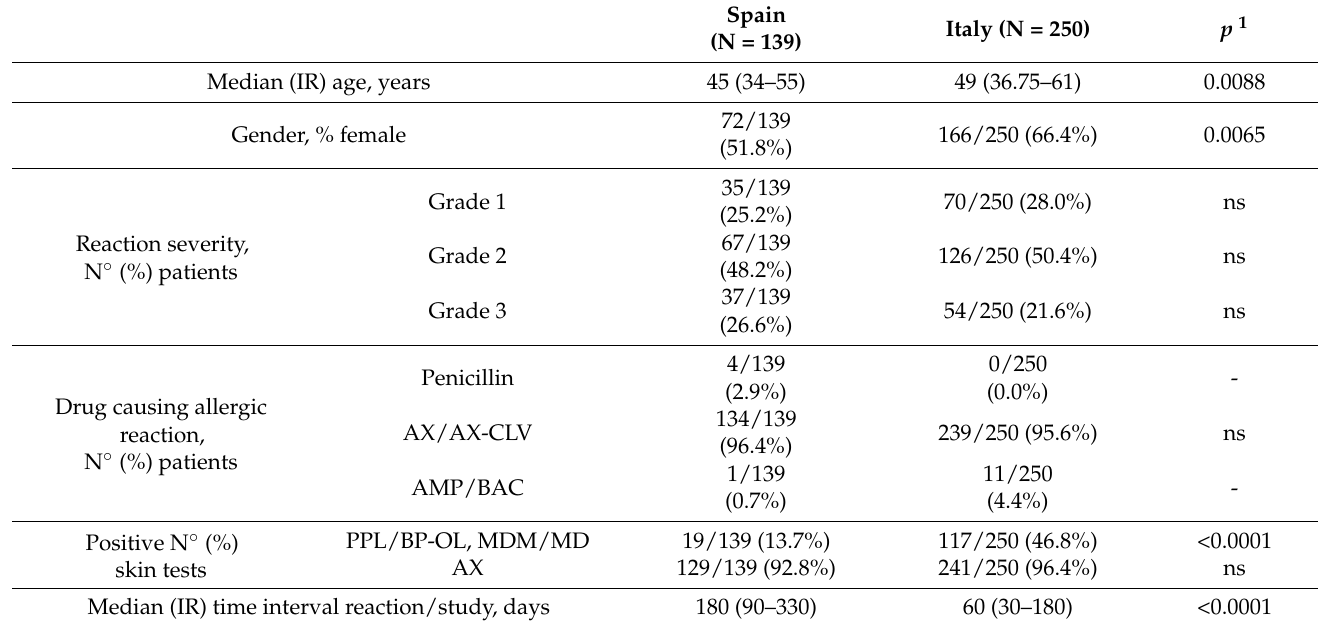
Table 1. Clinical characteristics, reaction severity, drugs involved, and skin test results for patients included in the study, and statistical comparisons of the Spanish and Italian study groups.